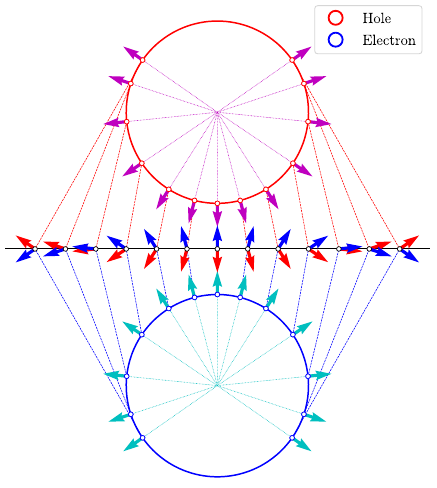
Figure 2. Momentum-space skyrmion textures of an electron and a hole. This idealized illustration corresponds to the configuration in a weakly bound exciton. Due to rotational symmetry the two circles actually represent only a radial slice of the two spheres onto which the complete momentum plane is mapped with a unit winding number. The south (north) pole of the top (bottom) sphere corresponds to the origin Q opposite pole corresponds to Q